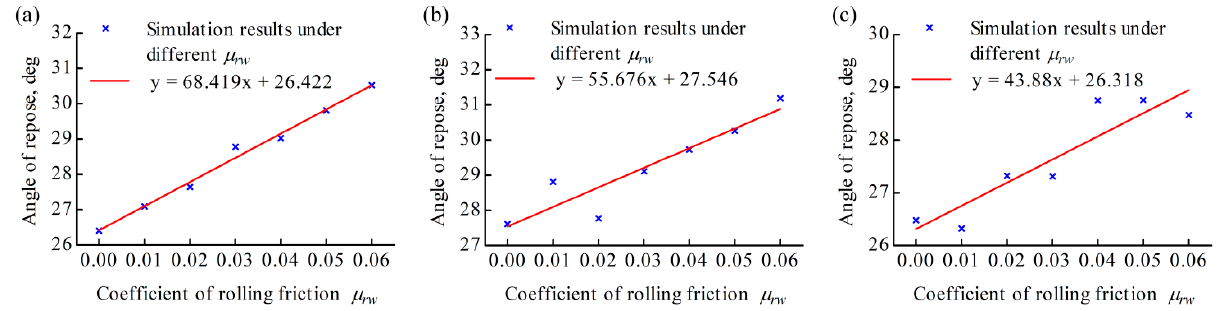
Figure 13. Calibration of the coefficient of rolling friction between seed particles and boundary for three maize varieties for three varieties: ( a ) Liangyu99, ( b ) Xianyu 335 and ( c ) Zhengda 999.